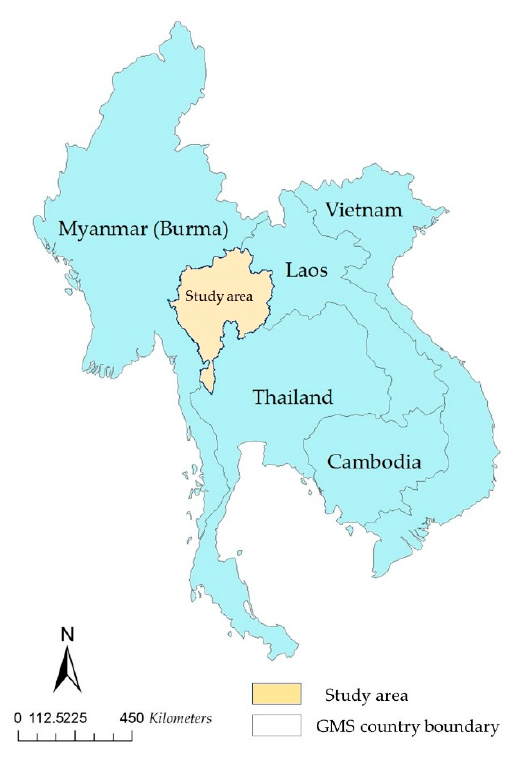
Figure 1. The Greater Mekong Subregion (GMS) map showing the study area.